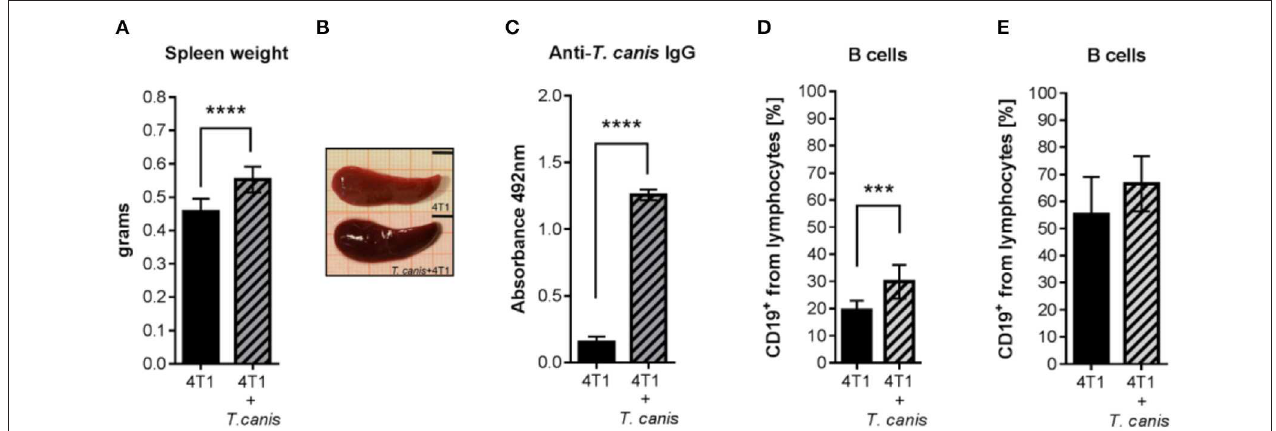
FIGURE 4 | Humoral response to T. canis infection in BALB/c mice. (A) Splenic weight. (B) Representative images of a spleen from a mouse with tumors (4T1 group) and of a spleen from a mouse with tumors and infection (4T1 + T. canis ). Millimetric grid as a background. Black bar = 0.5cm. (C) Anti- T. canis IgG serum levels measured by indirect ELISA. (D) Frequencies of CD19 + B lymphocytes in the spleen. (E) . Frequencies of CD19 + B lymphocytes in PLNs. Graphs represent the mean ± SD of the data from two experiments (4T1, n = 10; 4T1 + T. canis , n = 10). Statistical significance was calculated using a t -test (*** p ≤ 0.001; **** p < 0.0001).